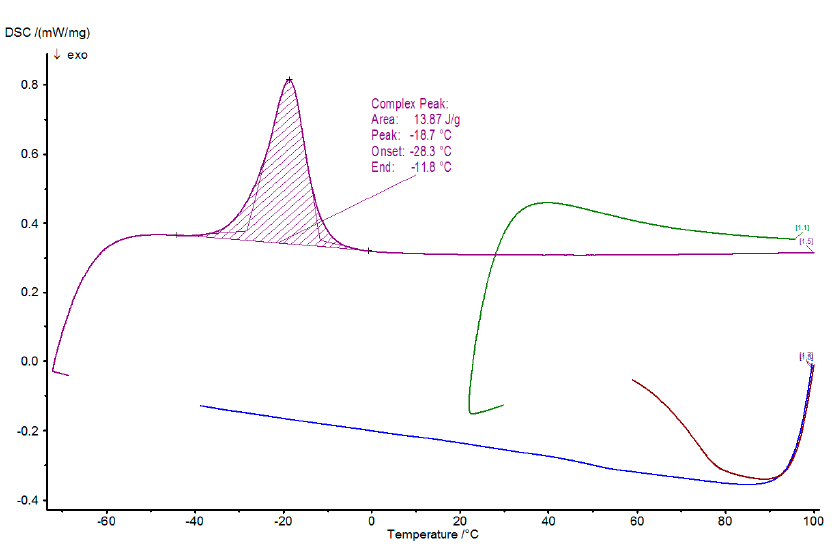
Figure 2. DSC result for the sample supplier